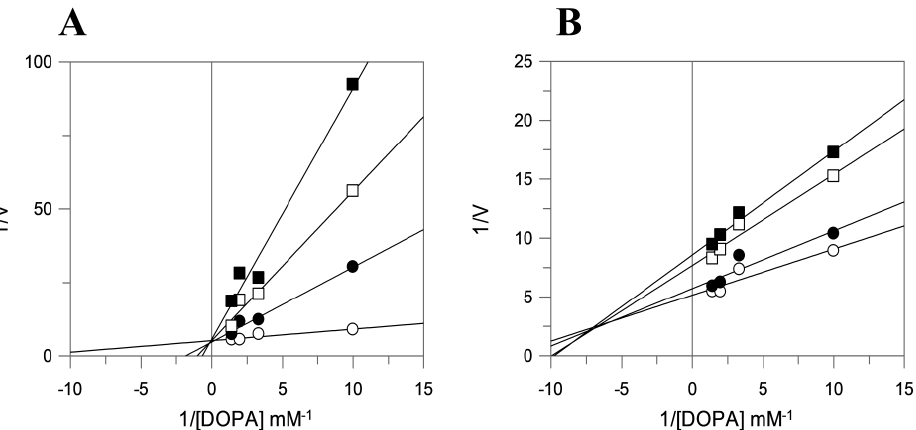
Figure 2. Lineweaver − Burk plots for inhibition of compound T1 ( A ) and T6 ( B ) on mushroom tyrosinase for catalysis of L-DOPA. Inhibitor concentrations were 0 ( ○ ), 1 μM (●), 5 μM (□), and 7 µM ( ■ ).